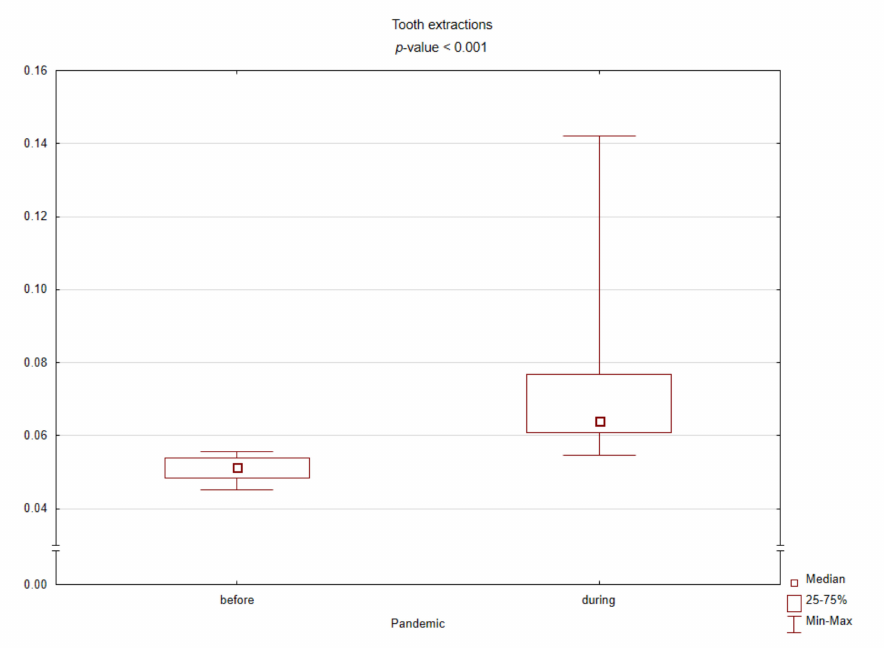
Figure 5. Box plot for the standardized number of tooth extractions before and during the COVID-19 pandemic ( p -value < 0.05 according to the Mann–Whitney